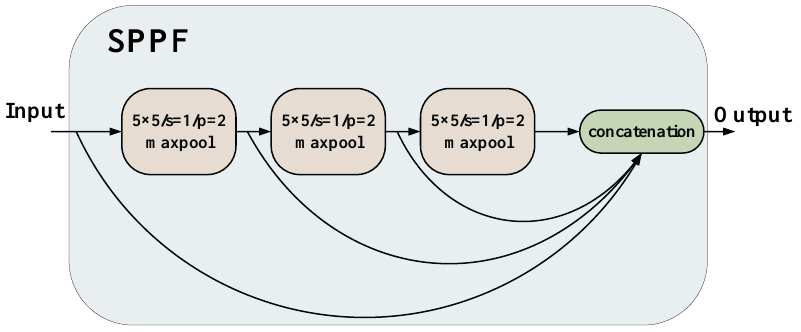
Figure 2. Schematic of the SPPF module.